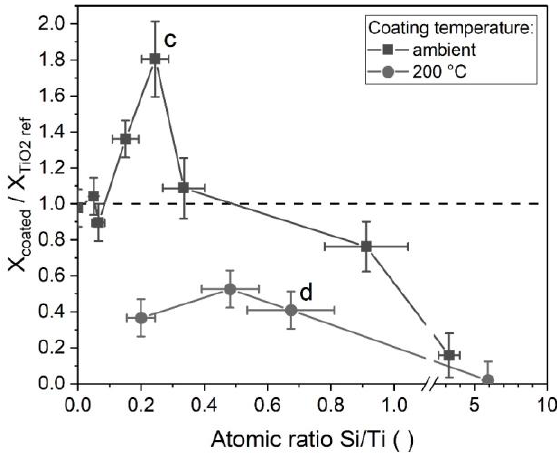
Figure 11. Ratio of the conversions of silica coated titania to reference samples of titania of equal mass in dependence on the coating amount after 1 h under UV radiation. c and d correspond to the respective TEM micrographs in Figure 2.